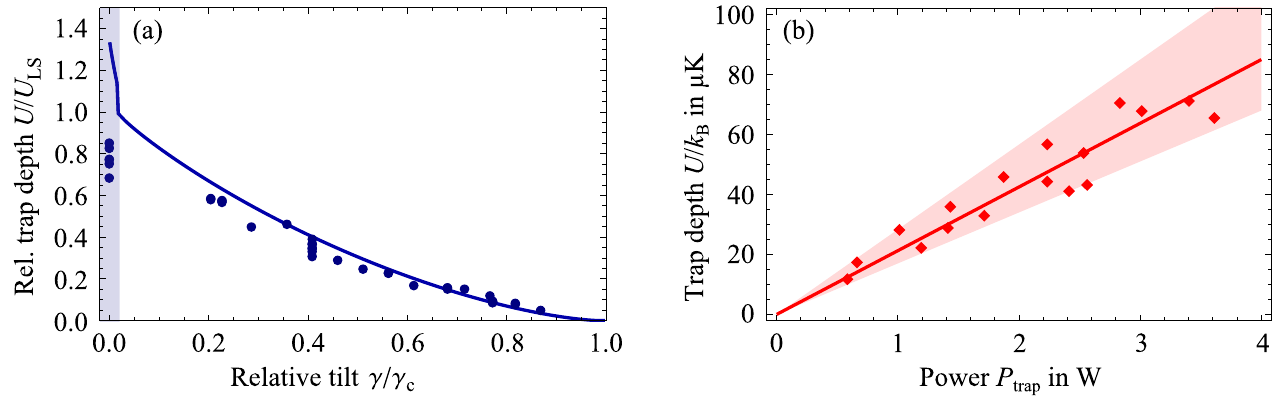
FIG. 5. (a) Relative 133 Cs trap-depth results from the fits to our data (dots) and theoretical model [Eqs. (A1) and (A3), line]. The trap depth is normalized with respect to the trap depth U the region where the horizontal confinement beams significantly contribute to the trap depth. (b) Absolute 7 Li trap-depth results from the fits to our data (dots). The solid line indicates theoretical knowledge of our trap [Eqs. (A1) and (A3), line], with w The shaded area accounts for the combined uncertainty of w